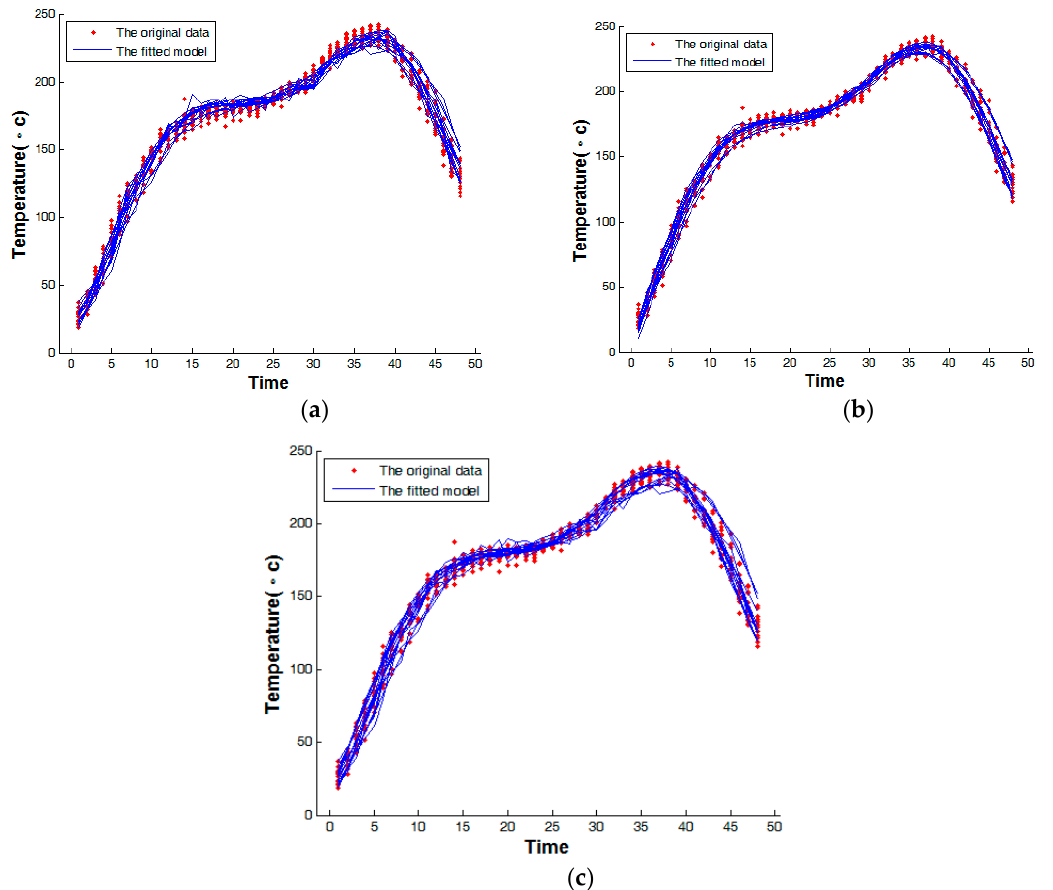
Figure 4. The fitting profile using the sum of sine model with AR(1) model. ( a ) The one-sine model; ( b ) The two-sine model; a d, ( c ) The three-sine model.